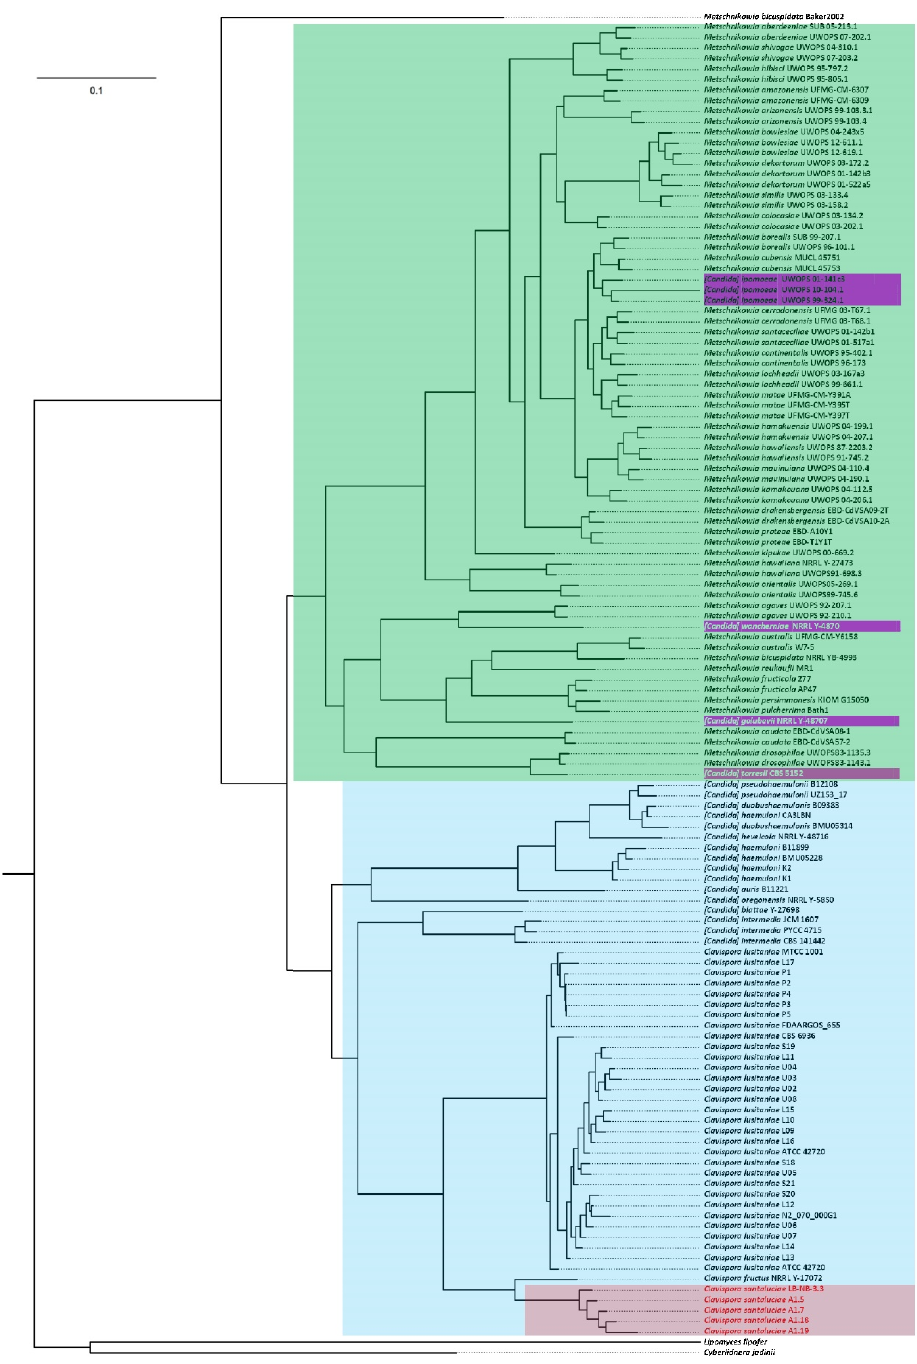
Figure 4. Phylogram of Metschnikowiaceae family showing the core proteome of 126 yeast strains (alignment of 2362 common proteins). Clavispora santaluciae genomes, sequenced in the present work, are highlighted using a red box, while Clavispora/Candida and Metschnikowia genera are highlighted by blue and green boxes, respectively. Incongruent locations are highlighted by purple boxes. Phylogenetic reconstruction was performed by considering maximum likelihood and 500 bootstrap replicates of the concatenated alignments. Bootstrap values were omitted as they were 100% for all branches.